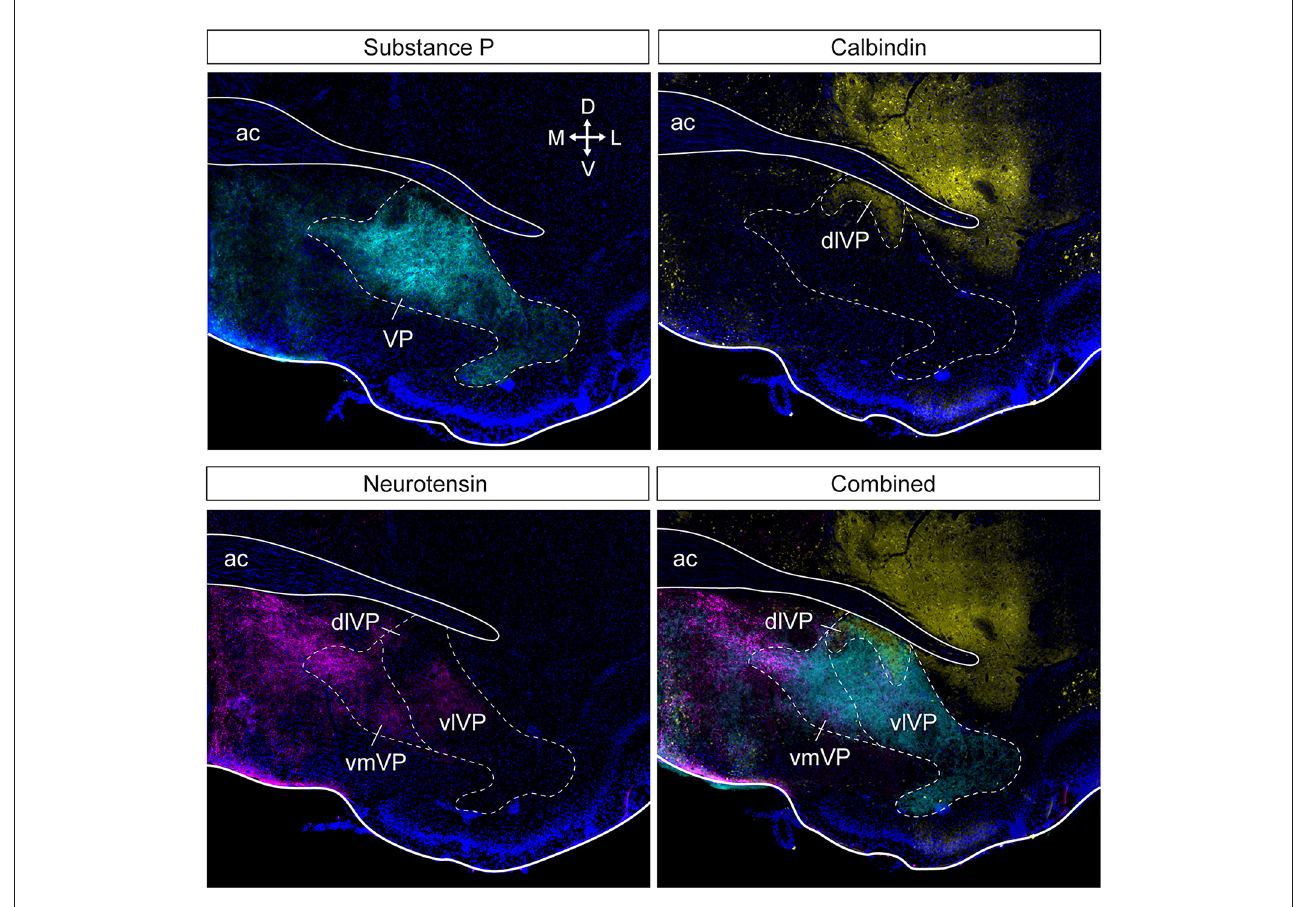
FIGURE2 Subdivision of the ventral pallidum into several functionally and histochemically distinct subregions. The series of adjacent sections (at bregma) were stained for substance P, calbindin, and neurotensin. Substance P (cyan) immunostaining shows the borders of the entire VP (top left). Calbindin (yellow) delineates the dlVP and ventral striatum (top right). Dense neurotensin labeling (magenta) outlines the vmVP and more sparse labeling or lack of labeling indicate the vlVP and dlVP (bottom left). The stains combined show the distinct subterritories of the VP. ac, anterior commissure; dlVP, dorsolateral ventral pallidum; vmVP, ventromedial ventral pallidum; vlVP, ventrolateral ventral pallidum. Arrows indicate the orientation of the brain along the dorsoventral (DV) and mediolateral (ML) axes. Sections are counterstained with DAPI (blue). Figure adopted from Zahm et al. (1996) and Heinsbroek et al.